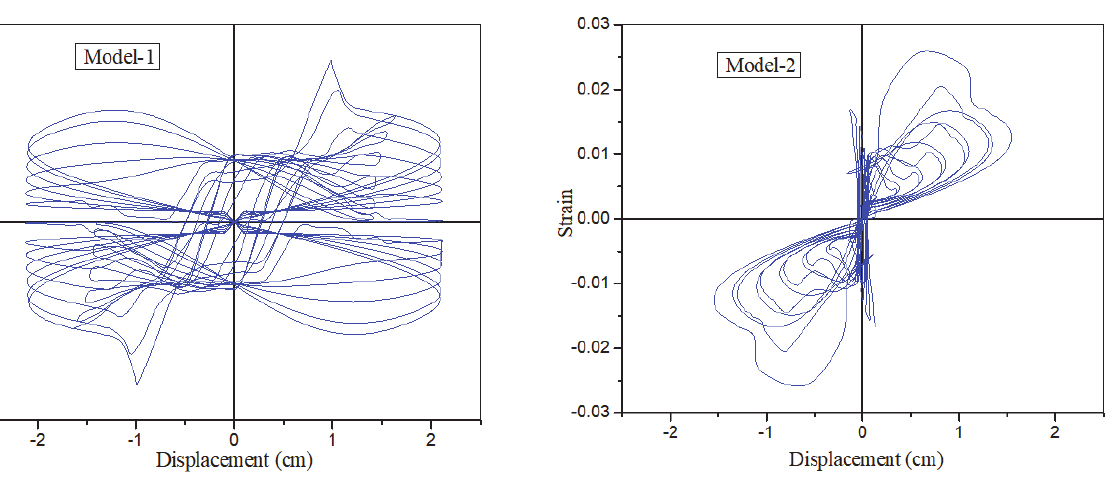
Figure 7: Strain Vs displacement on timber beam with 3.3 (m) length, model-1.